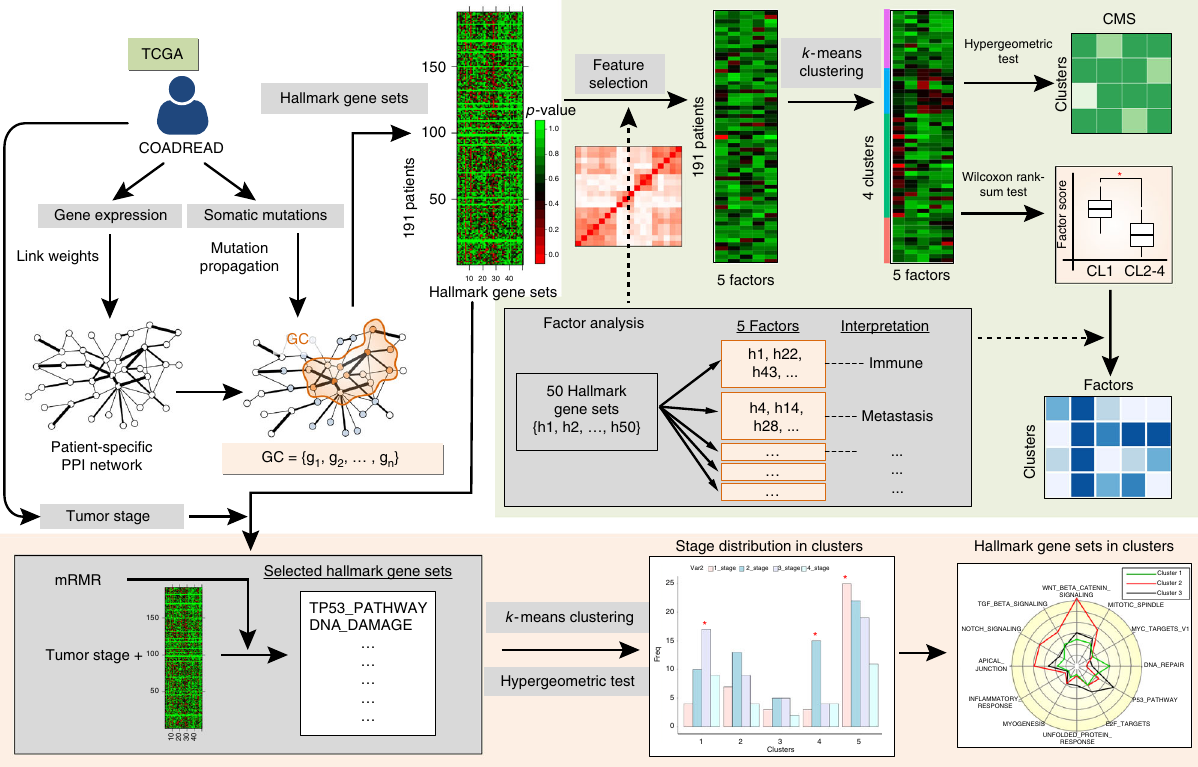
Fig. 3 Hallmark gene set analysis. Flowchart of the hallmark gene set analysis for identifying hallmark gene sets enriched in the GC and for classifying cancer patients based on the selected features using factor analysis and the mRMR feature selection method (see Methods for